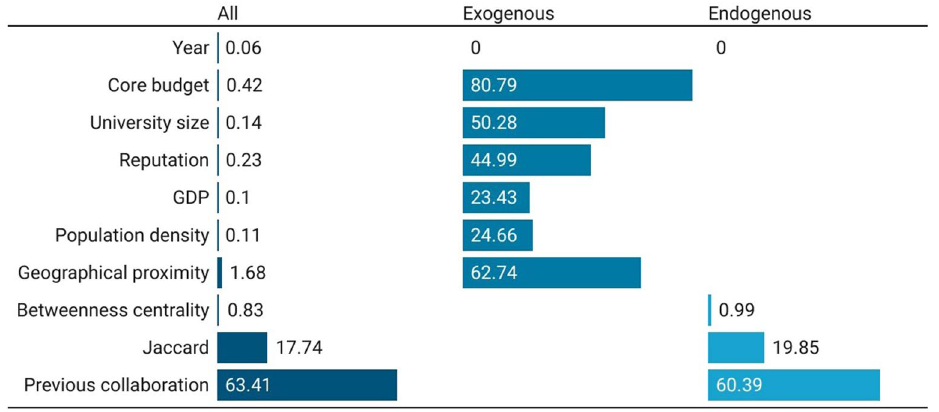
Figure 4. Feature-importance scores for European universities’ co-publication prediction in Physical and Engineering Sciences. Three models considered: with all, with only exogenous, and with only endogenous features. For convenience, features’ importance is averaged across years and universities to be better presented